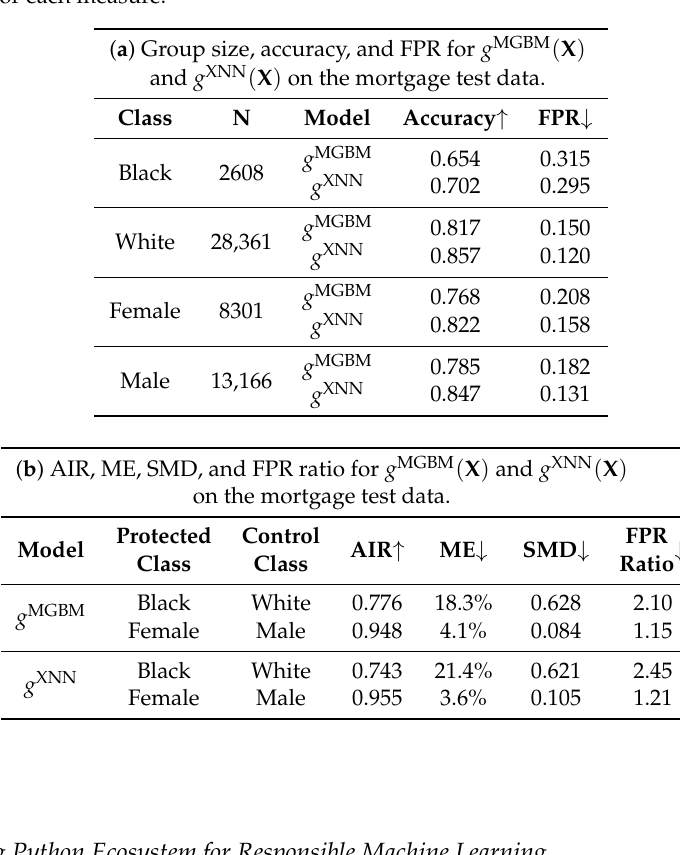
Table 3. Discrimination measures for the mortgage test data. Arrows indicate the direction of improvement for each